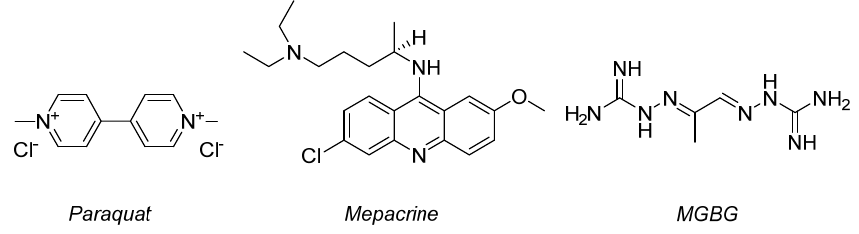
Figure 3. Synthetic polyamines that penetrate cells.